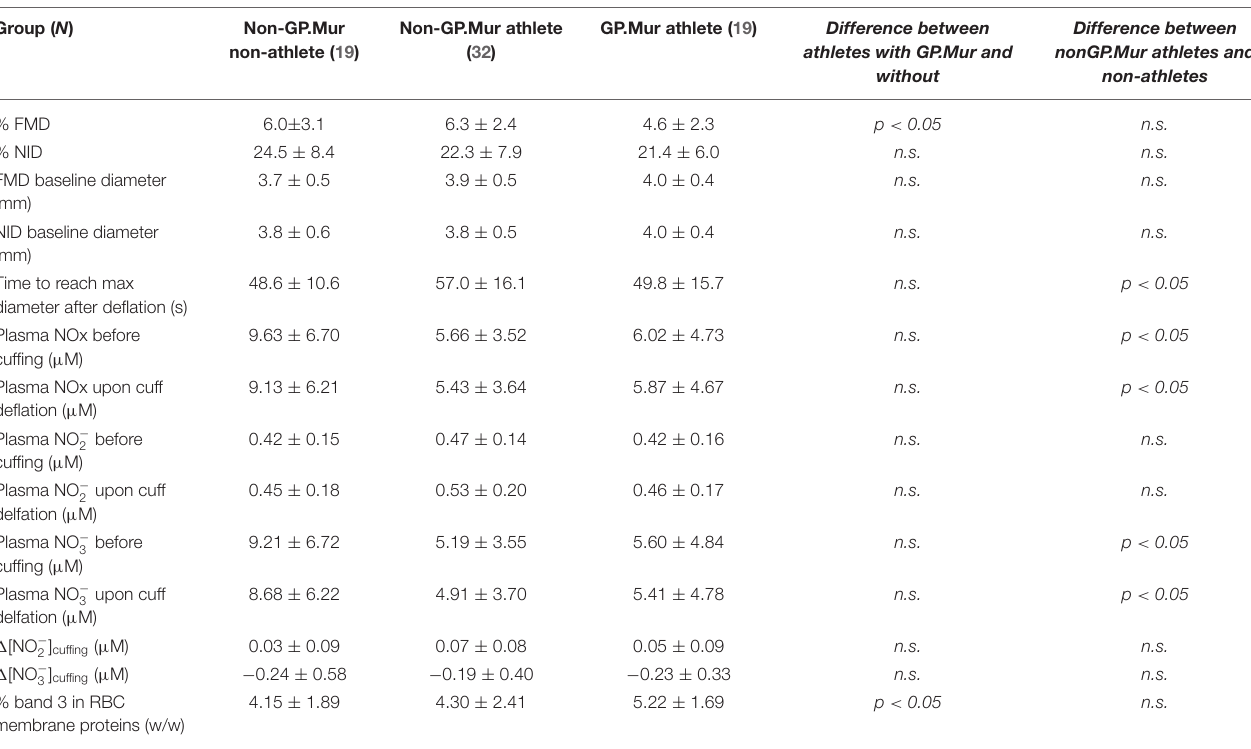
TABLE 2 | FMD, NID, blood plasma NO metabolites, and band 3 levels on RBCs. Group ( N ) Difference between